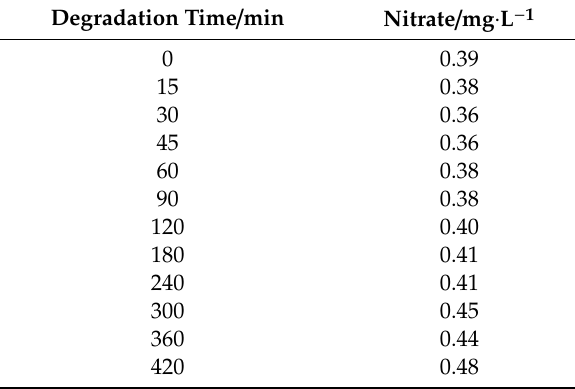
Table 1. Data of nitrate concentration as function of degradation time, obtained through ion